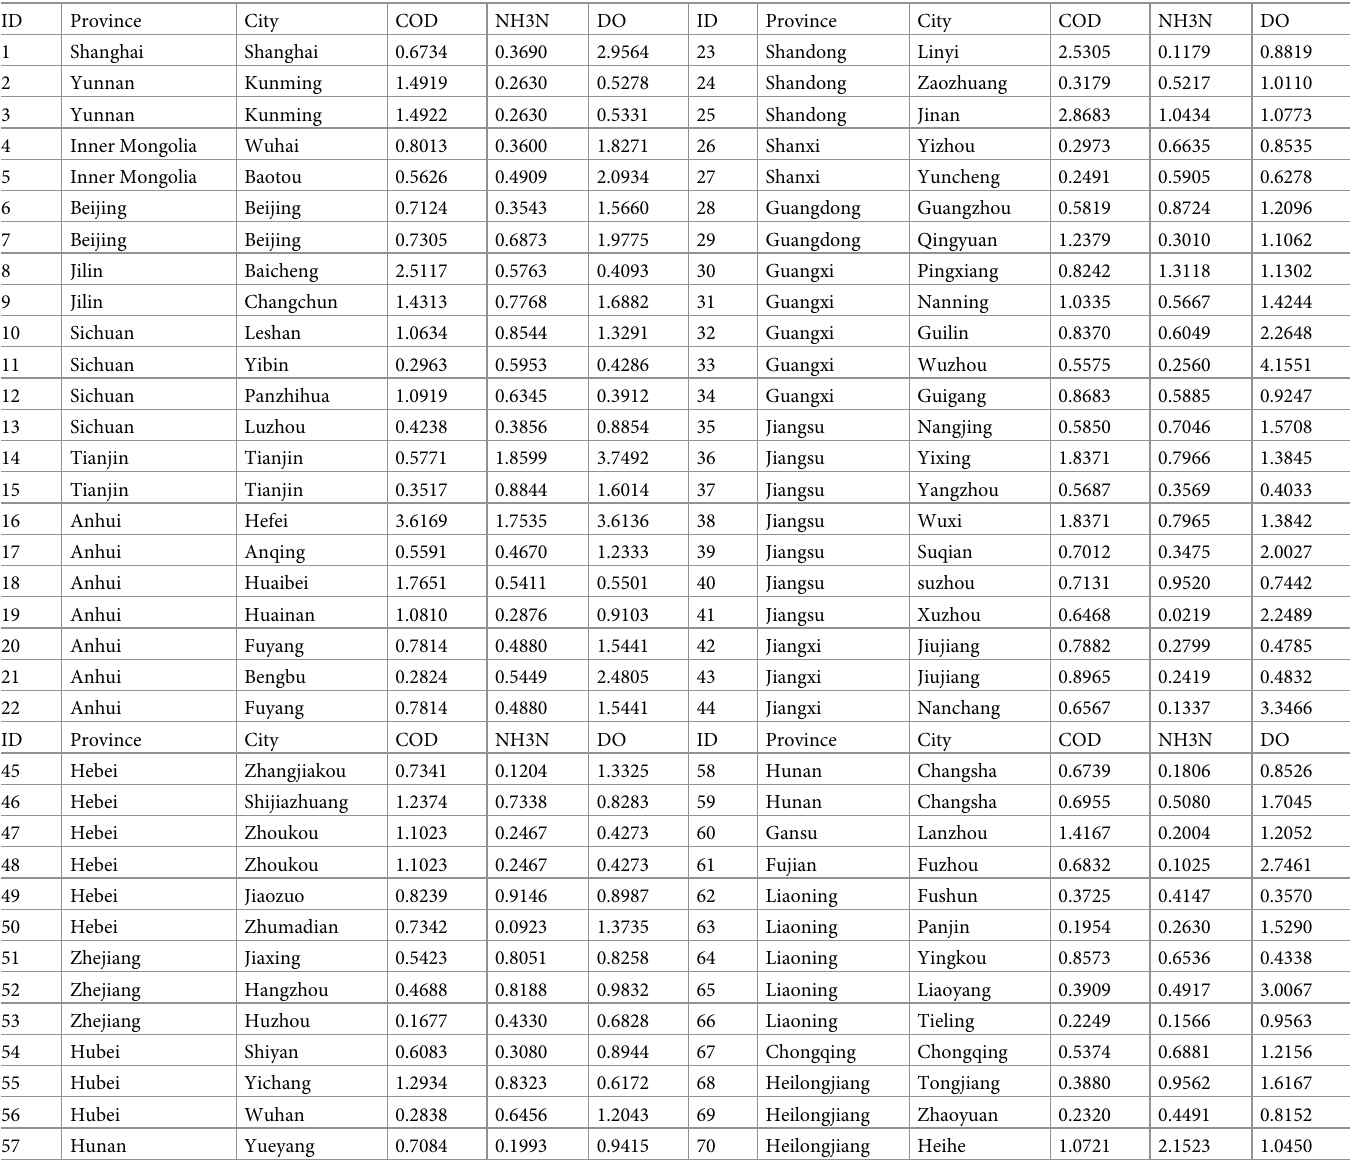
Table 8. Ratio of the RMSPE after and before the administrative division adjustment (post-RMSPE/pre-RMSPE).